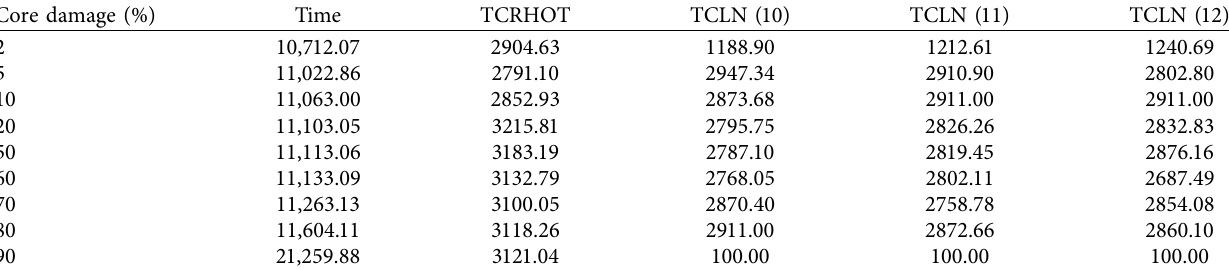
Table 15: Time and temperature distribution due to core damage.